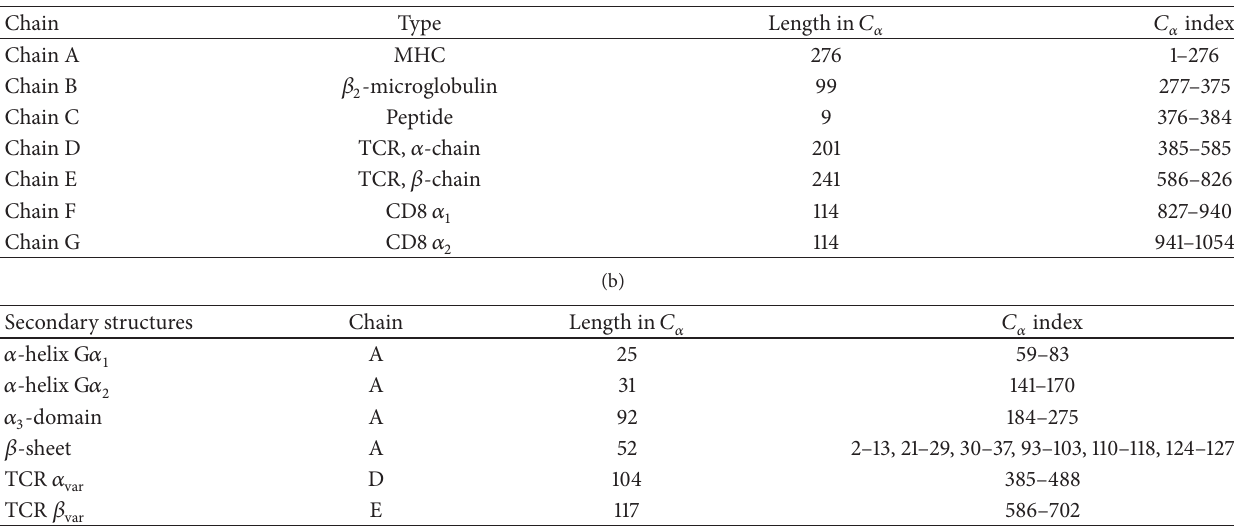
Table 1: Molecules and their secondary structural elements.